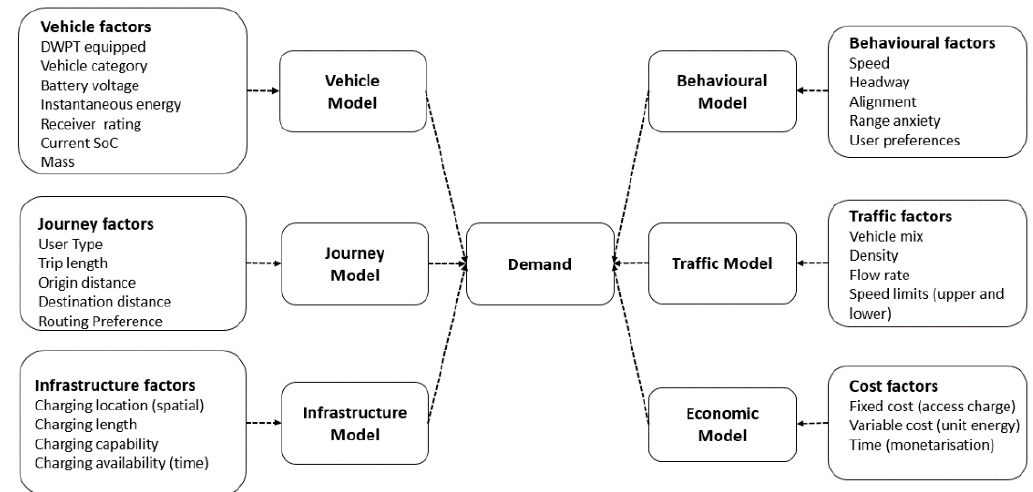
Figure 2. Taxonomy—linking Factors identified from focus groups to demand.